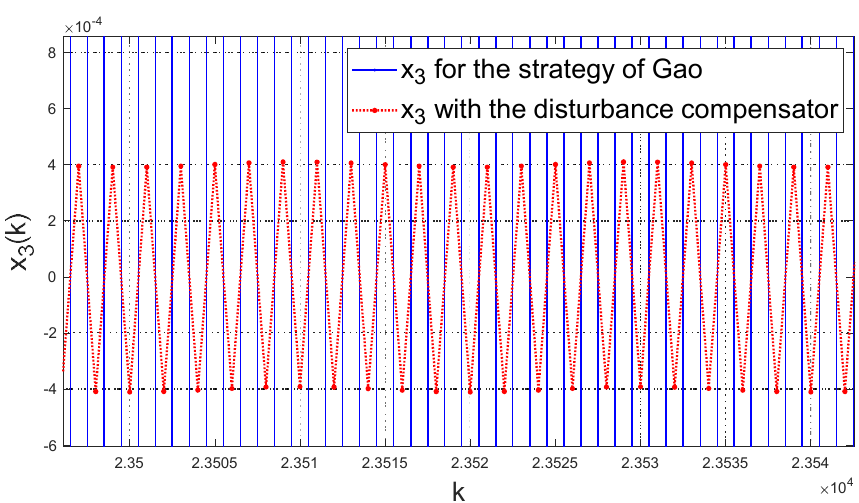
Figure 14. x 3 ( k ) for both control strategies in the sliding phase (zoomed).